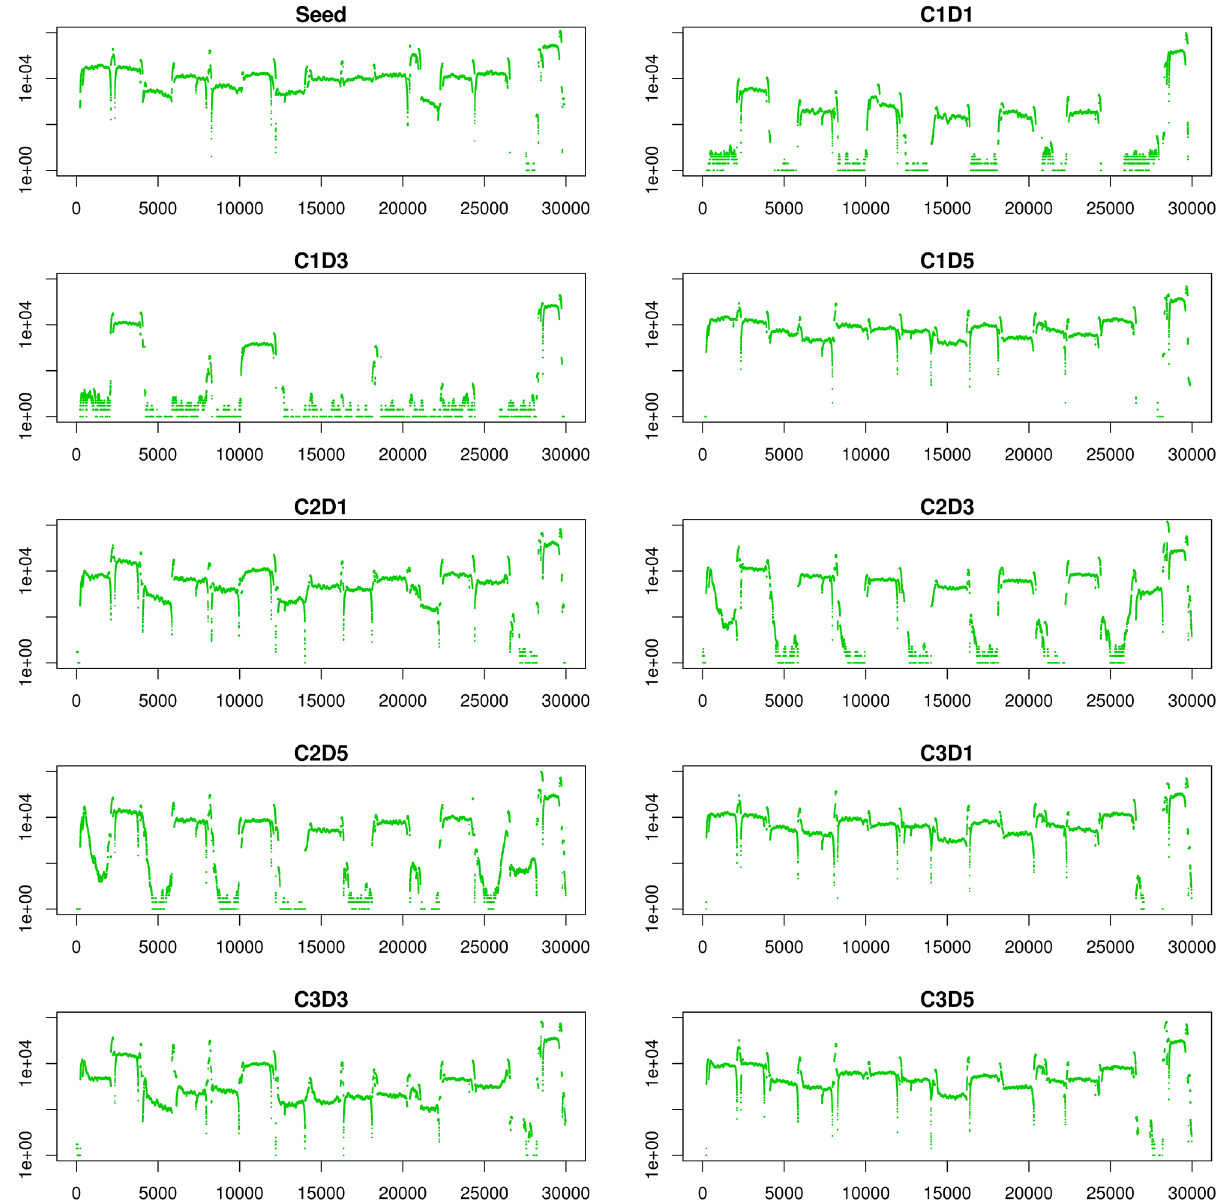
Fig 1. Coverage Plots. UDS coverage depth across the genome was plotted for each sample. The X axis shows the genome position and the Y axis shows the depth coverage (log